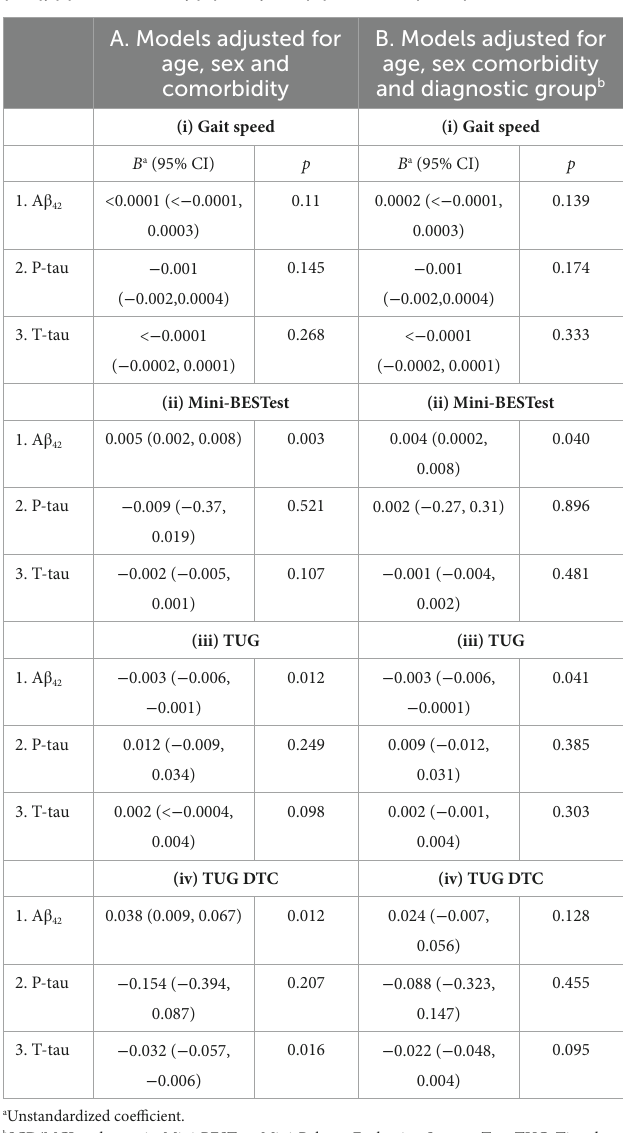
TABLE 4 Associations between CSF AD core biomarkers and (i) Gait speed (m/s), (ii) Mini-BESTest, (iii) TUG, and (iv) TUG DTC ( n =